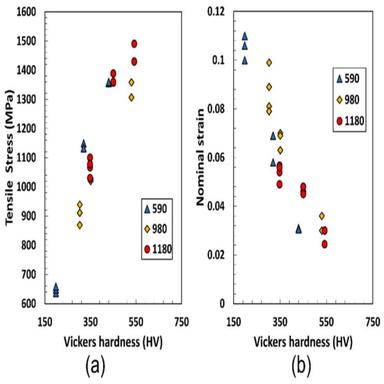
Relationship between hardness measurement results and miniature experimental results. (a) Vickers hardness and tensile stress, (b) Vickers hardness and nominal strain at the maximum tensile stress.